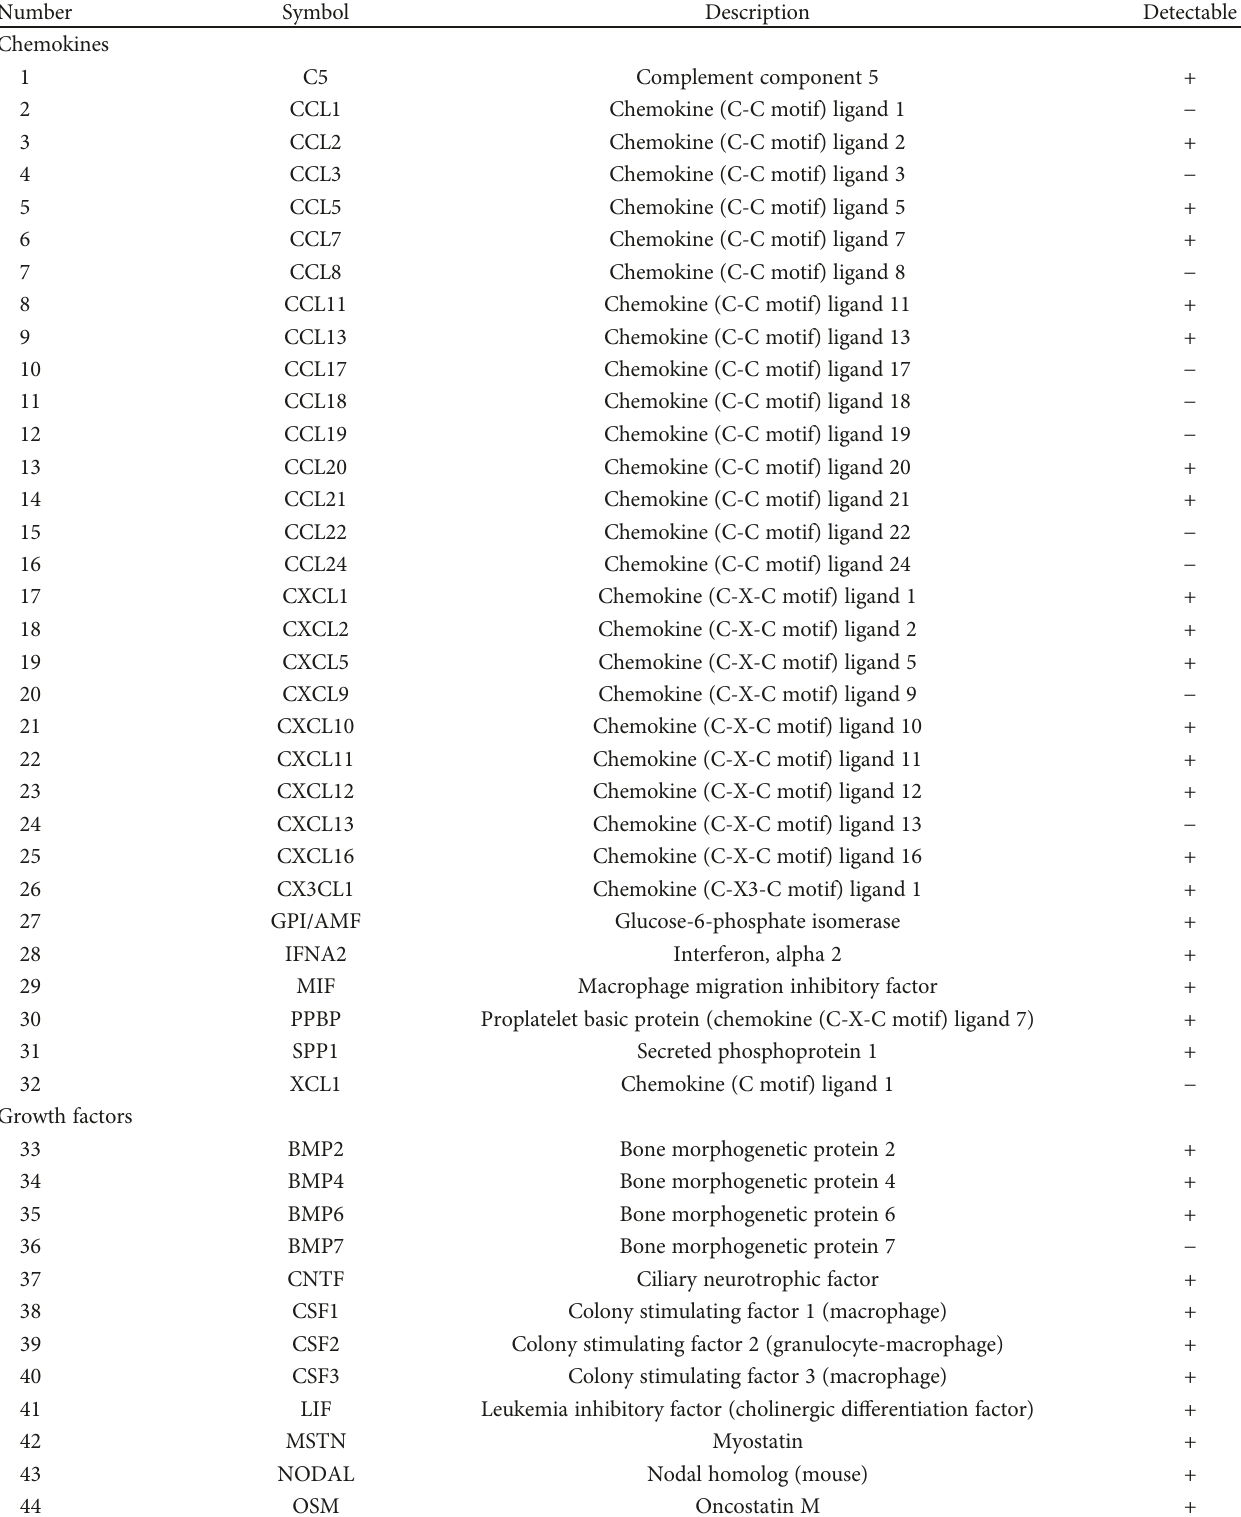
Table 1: Human Cytokines & Chemokines RT 2 Pro fi ler PCR Array (Qiagen). Abbreviation (symbol) and full name/function (description) of the 84 cytokines and chemokines analyzed by the PCR array. The column “ detectable ” indicates whether the factor was detected (+) or not detected ( − ) within this